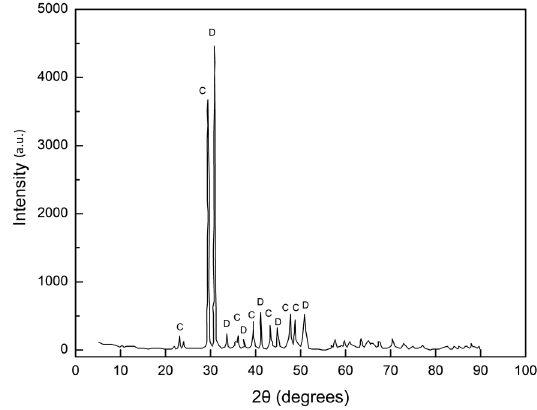
Figure 3. Marble residues X-ray diffractogram